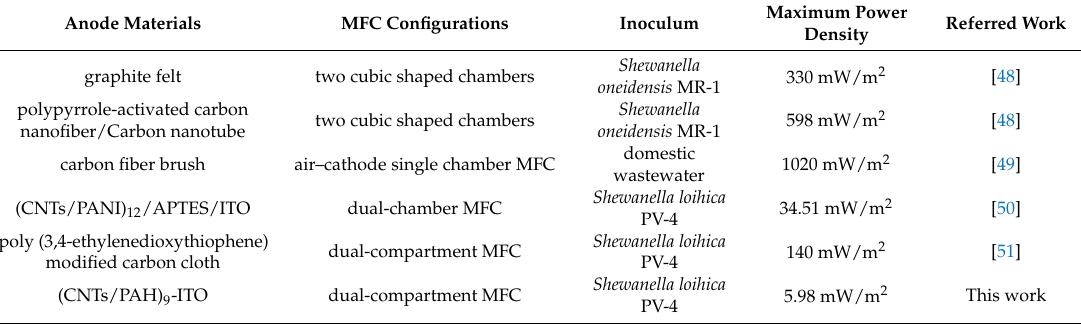
Table 2. Composition of the maximum power densities of anodes in the